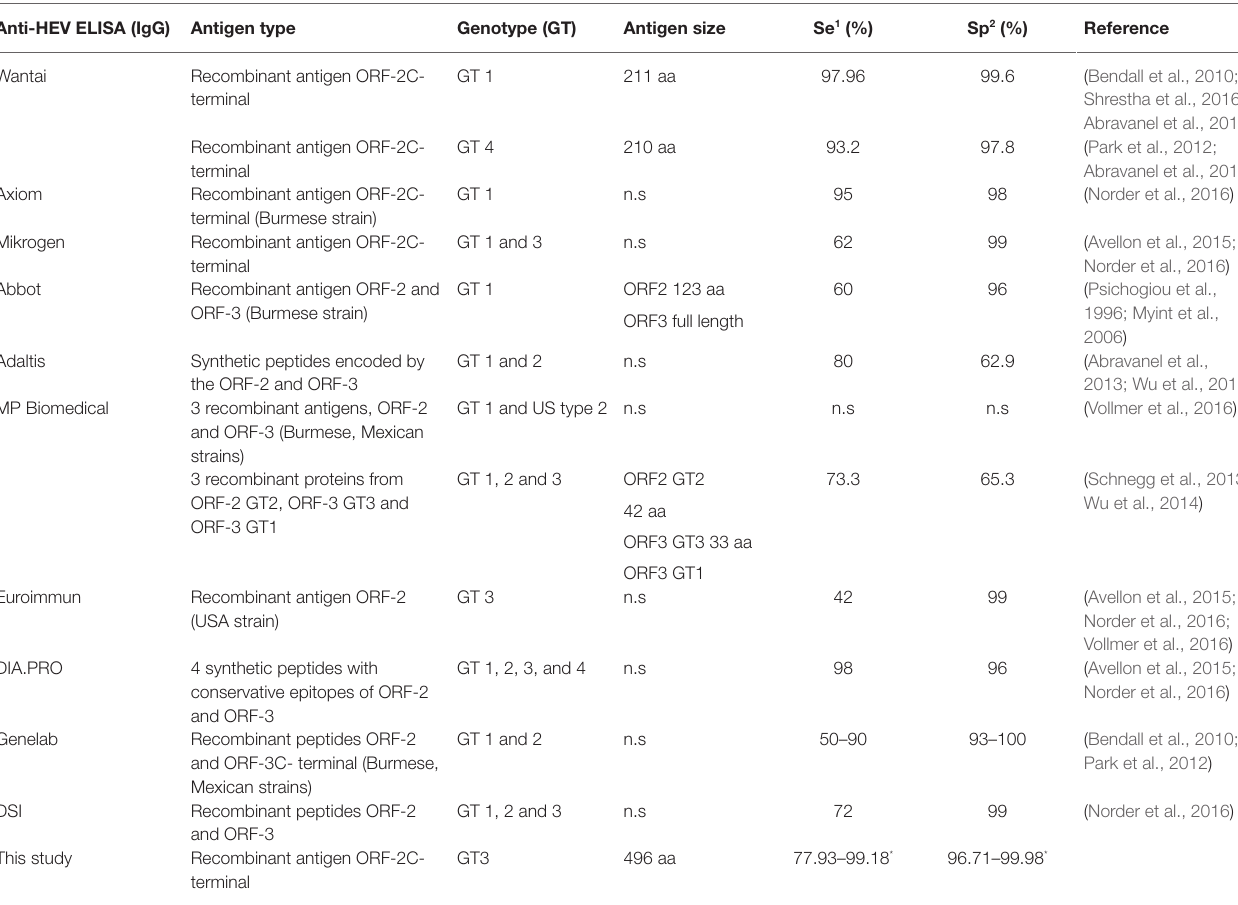
TABLE 2 | Comparison of commercial ELISA tests for Hepatitis E and the in-house ELISA developed in this